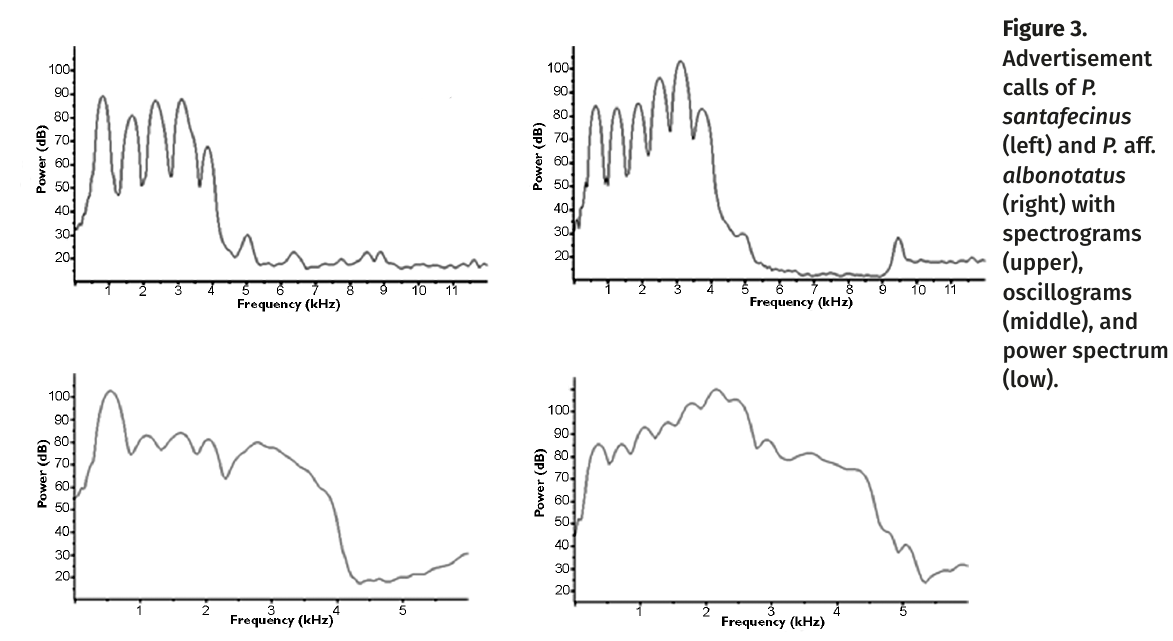
Advertisement calls of P. santafecinus (left) and P.